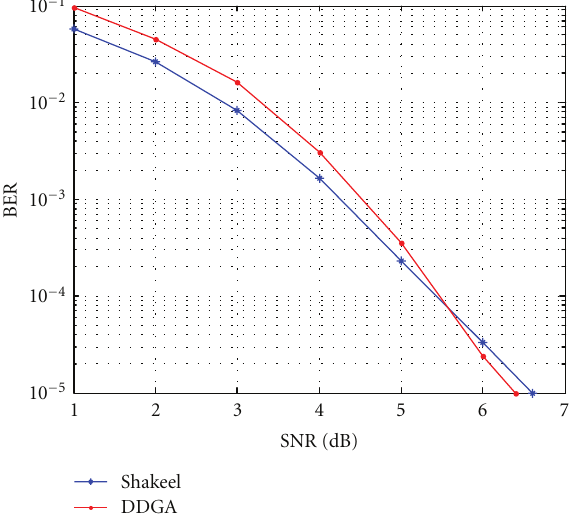
Figure 23: Performances of DDGA, and Shakeel algorithms for BCH(31,21,5) code over RC.